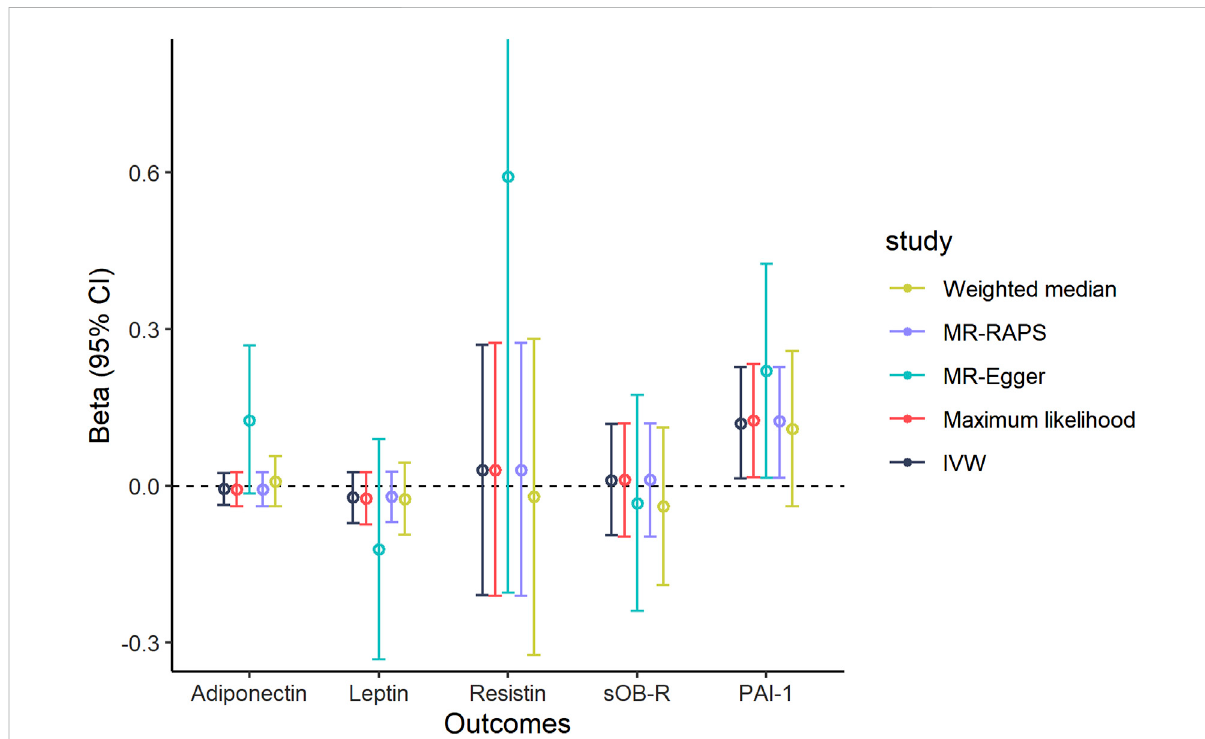
FIGURE 3 Causal association of genetically predicted PET and circulating adipokine levels according to different Mendelian randomization methods. Abbreviations: IVW, inverse-variance weighted; MR-Egger, Mendelian randomization Egger; MR-RAPS, Mendelian randomization robust adjusted pro fi le score; 95% CI, 95% con fi dence